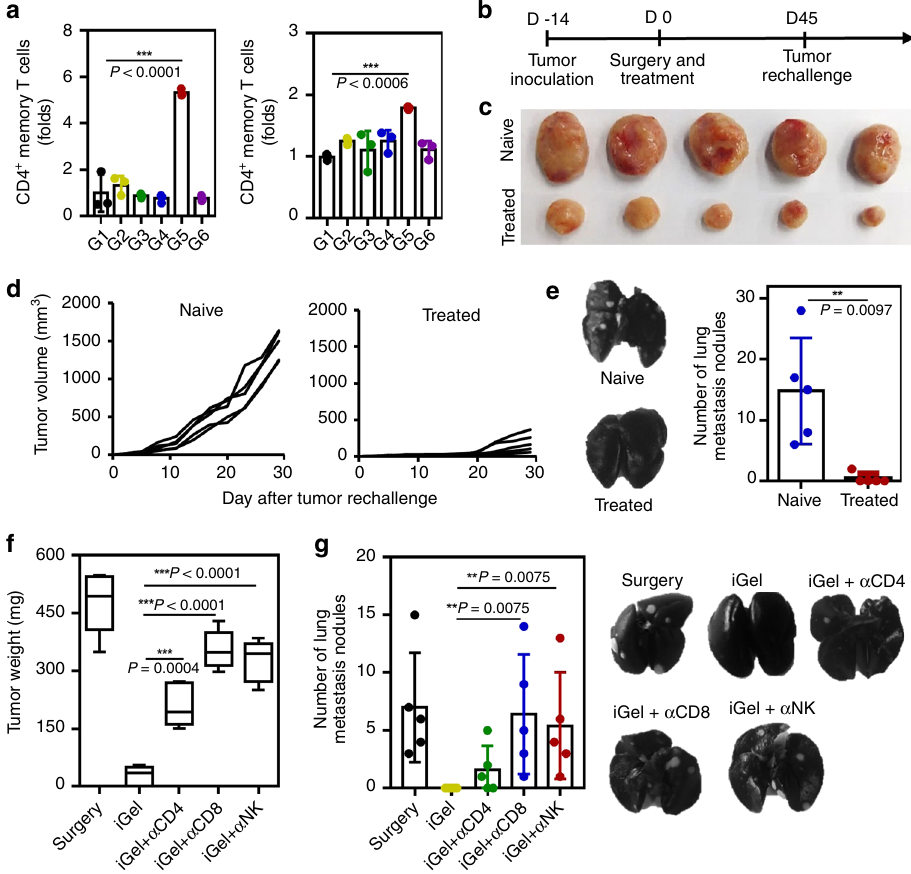
Fig. 7 Syringeable iGel for memory T-cell response. a Splenocytes isolated from tumor-bearing mice were analyzed for the presence of memory T cells gated on CD4 + and CD8 + cells ( n = 3). b Treatment schedule for the tumor rechallenge experiment. c Tumor image and d tumor volume of naive and treated (tumor-free mice after iGel treatment, G5 group) mice. e Representative images of lungs collected from mice 30 days after tumor rechallenge. White nodules indicate metastatic tumors in the lungs. Number of metastatic lung nodules ( n = 5). f Weight of recurring tumors after treatment with iGel. Speci fi c immune cell subsets were depleted using anti-CD4 ( α CD4), anti-CD8 ( α CD8) and anti-CD49b ( α NK) antibodies to reveal their relative contributions ( n = 5). g Number of metastatic lung nodules. Data are presented as the mean ± SD ( n = 5). For a and f , P- values were determined by one- way ANOVA and Tukey ’ s test. For e and g , P -values were determined by Mann – Whitney test. The results are representative of one of two